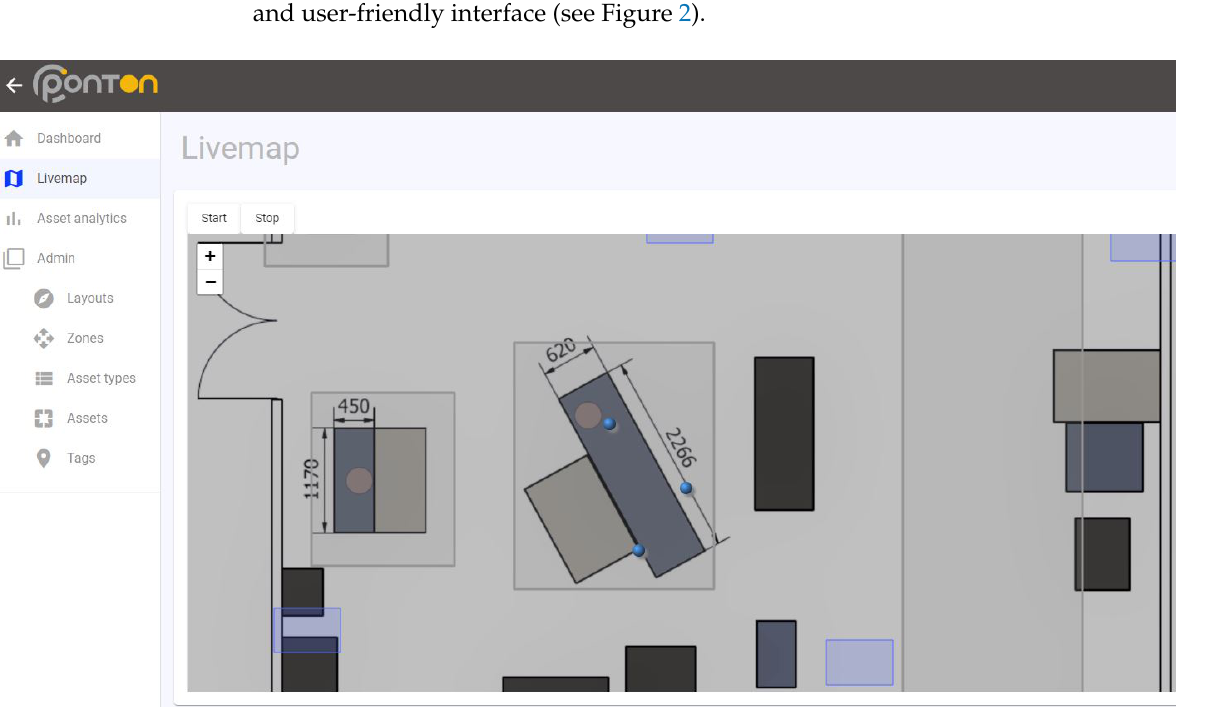
Figure 2. Interface of the IPS with the position of the tags (blue dots) and the layout of the